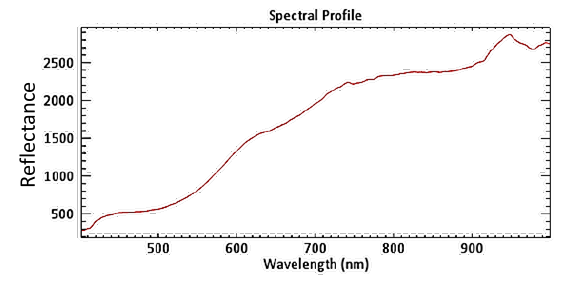
Figure 2: Target spectra of brick kilns The ACE algorithm is applied on the data to generate target map as described in section 3.1 with threshold value of 0.25. The target map of brick kiln locations in the scene is given in figure 3a where white spots represent the detected brick kiln’s locations. Two such spots are highlighted in red and yellow dots in figure 3a for which high resolution images are shown in figures 3b and 3c respectively. It is observed in this figure that Brick kilns are detected correctly and this shows the case of true positive detection.